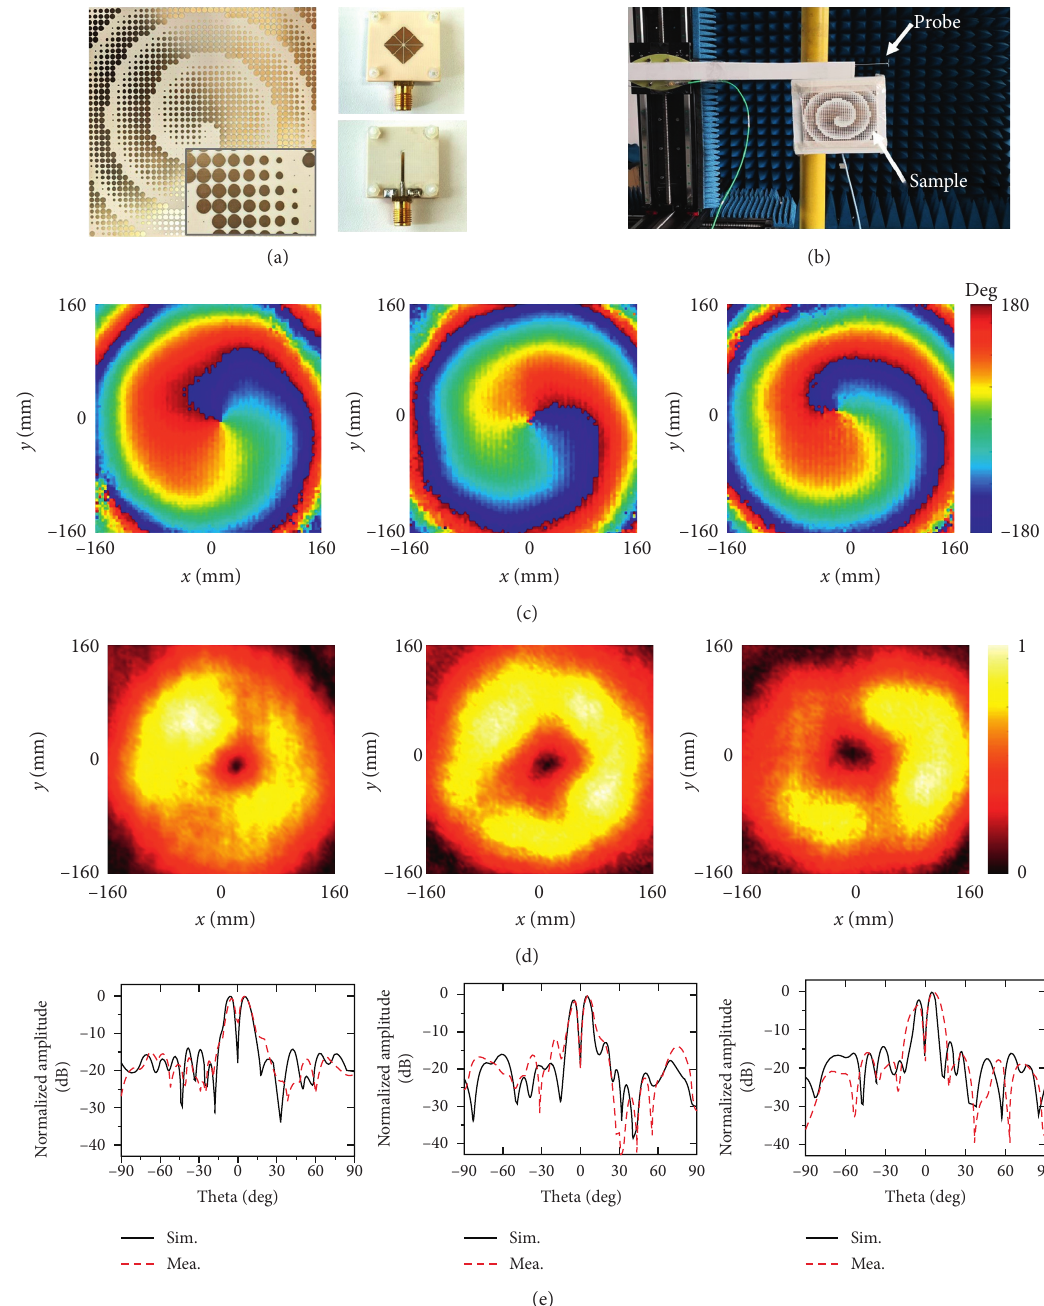
Figure 5: (a) Photograph of the fabricated metasurface (left panel) and feed source (right panel). (b) Experimental setup for electric field mapping. (c) Measured distribution of the transmission phase. (d) Measured distribution of the transmission amplitude. (e) Measured far- field 2D radiation pattern at 11.5GHz (left panels), 13GHz (middle panels), and 13.5GHz (right